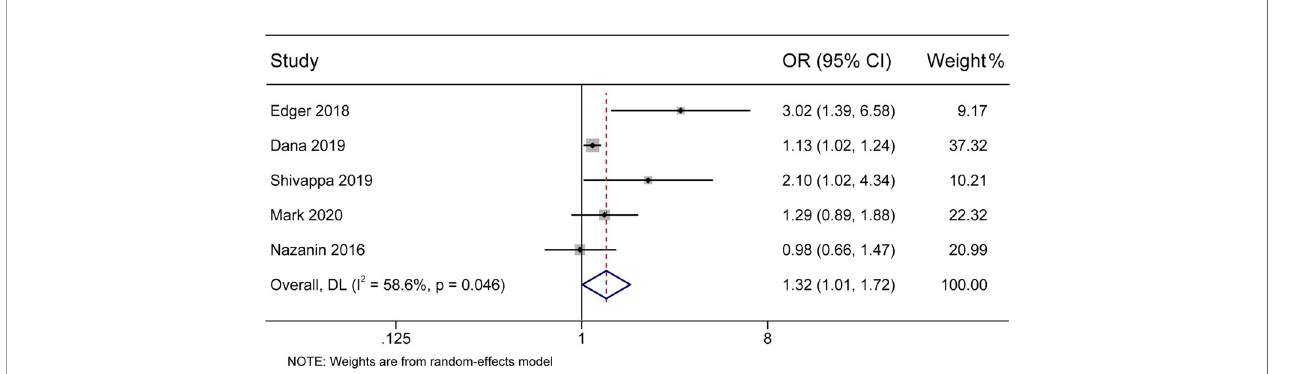
FIGURE 2 | Forest plot showing the association between the DII and the risk of diabetes mellitus. Higher DII scores were associated with an increased incidence of